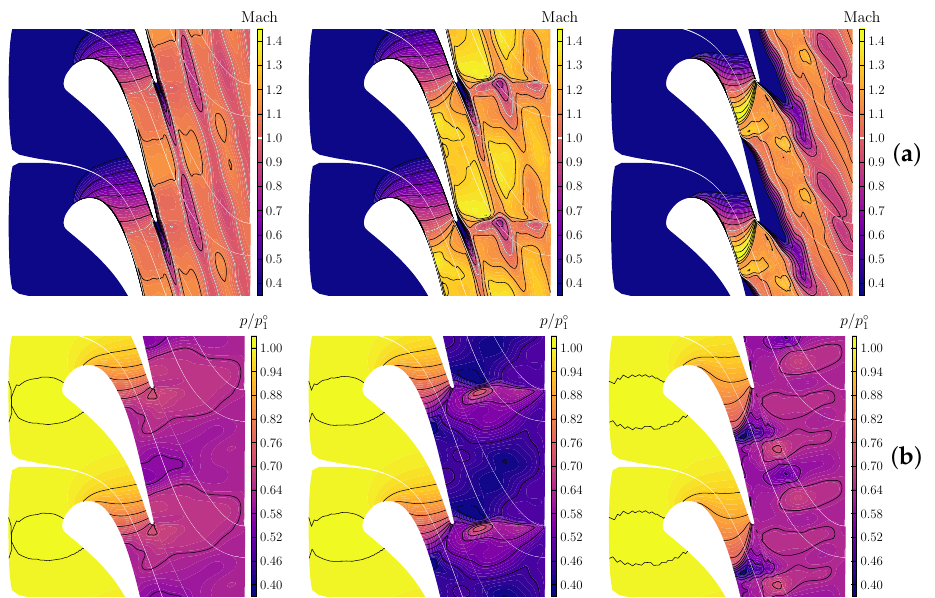
Figure 8. Reynolds-averaged Navier–Stokes (RANS) results for the Mach number ( a ) and normalized pressure p / p ◦ ( b ). Cases IC1-LPR ( left ), IC1-HPR ( middle ), and IC2-LPR ( right ). For the latter case, the time-averaged unsteady RANS solution is presented.